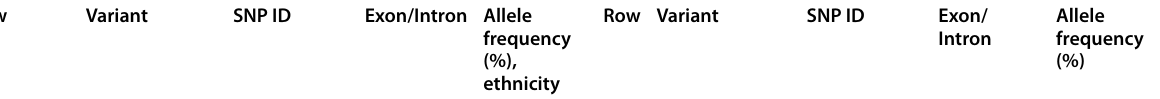
Table 1 PTS gene variants reported among Iranian